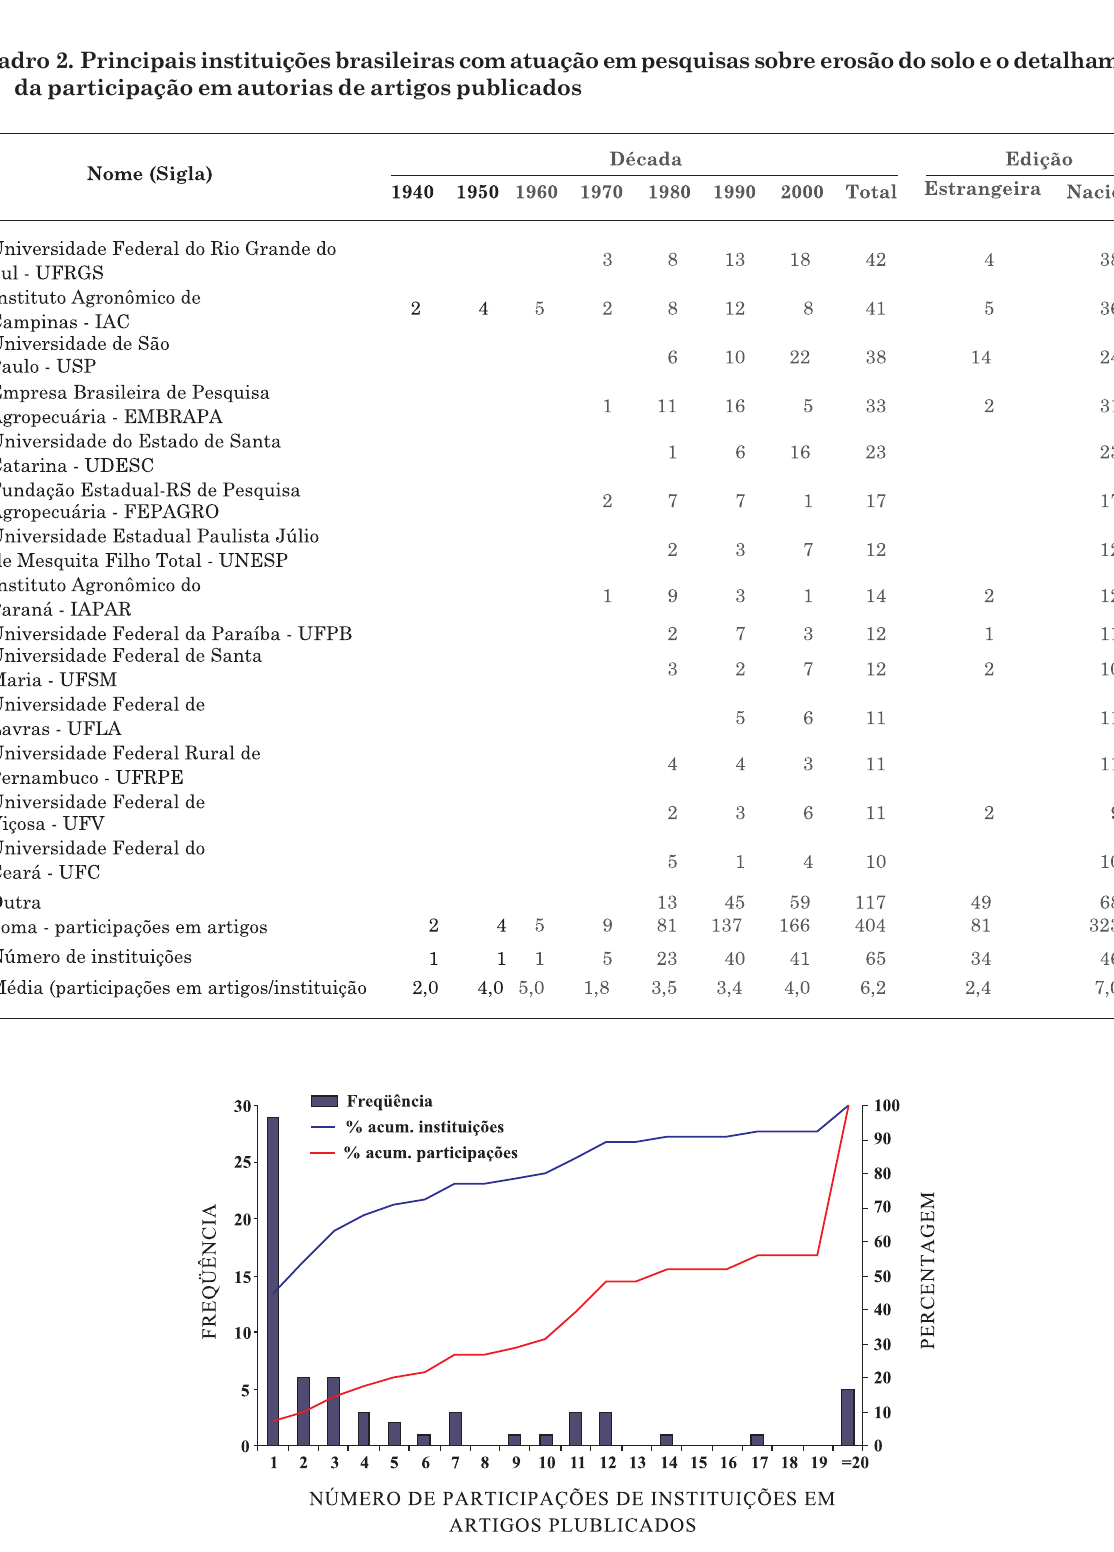
Outra marca importante da polarização